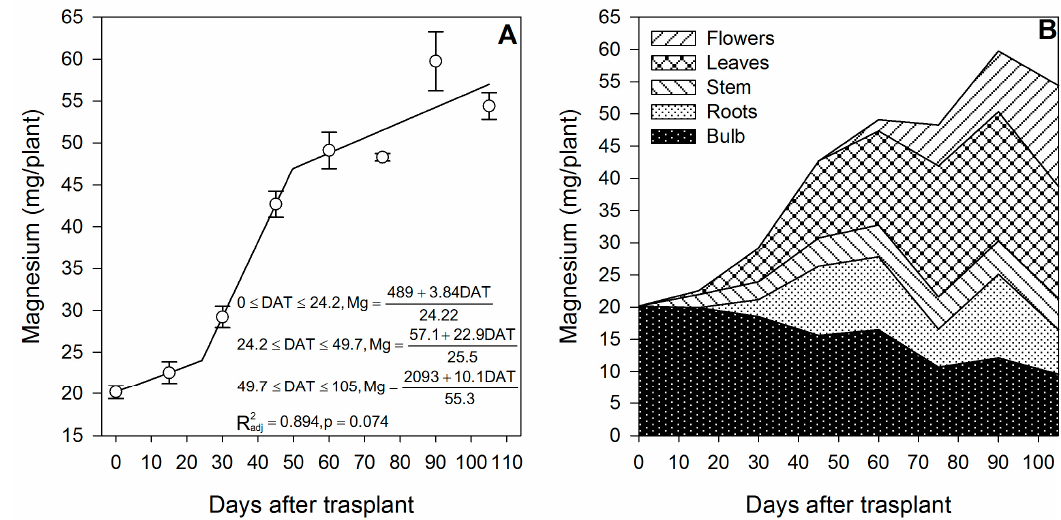
Figure 6. Magnesium accumulation in lilium: ( A ) Segmented analysis of magnesium accumulation over the growing season; ( B ) Magnesium distribution in the lilium plant parts. Day 0 = transplant day, days 0 to 15 = sprouting and initial vegetative growth, days 15 to 60 = rapid vegetative growth plus flower buds formation, days 60 to 105 = blooming. DAT = days after transplant.